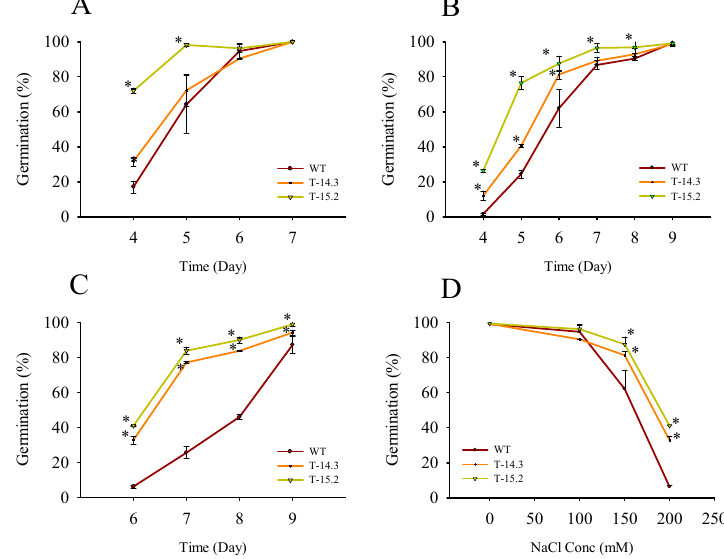
Figure 11. Seed germination rates of WT and AnnAt8 overexpressing transgenic tobacco plants under salt stress. ( A – C ) are day wise seed germination percentages on 100, 150 and 200 mM NaCl concentrations, respectively; ( D ) NaCl dose response on seed germination. For each biological replicate (n) 150 seeds of WT and transgenic lines were taken. Data represent means of n = 3 ± SE. An asterisk indicates that the mean values of transgenic lines were significantly higher than that of WT, when analyzed by one-way ANOVA ( p < 0.05).